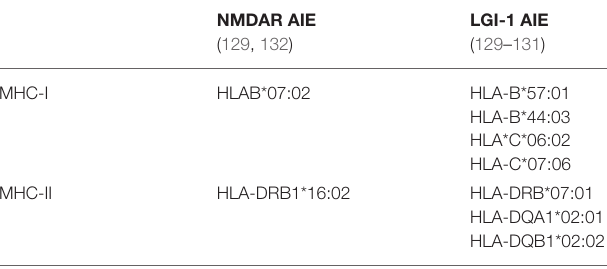
TABLE 4 | HLA haplotypes associated with AIE